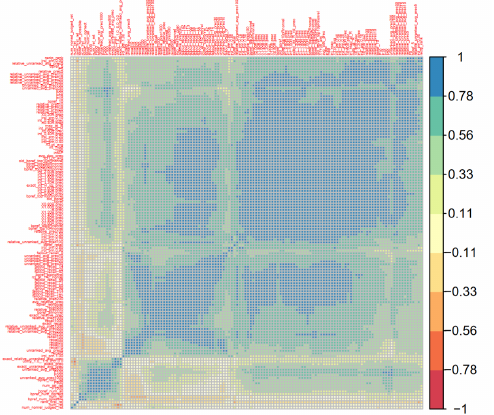
Figure 19. When considering a given system and a given query, the effectiveness measure used to compare the systems does not matter much: all are strongly correlated. Pearson correlation values between two effectiveness measurements on two measures for a given (system, query) pair. Correla- tions are represented using a divergent palette (a central colour, yellow, and 2 shades depending on whether the values go for negative—red—or positive